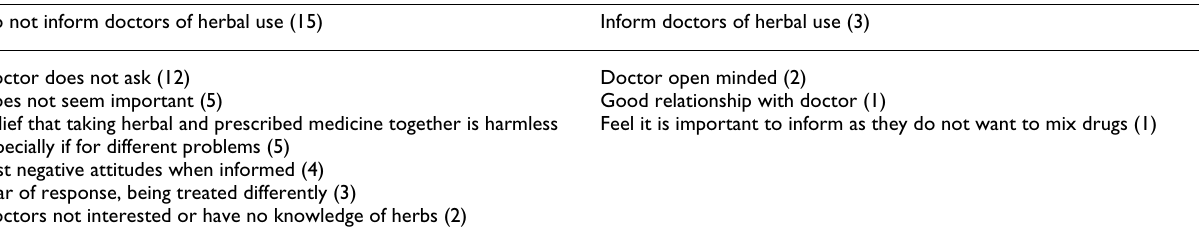
Doctor open minded (2) Good relationship with doctor (1) Feel it is important to inform as they do not want to mix drugs (1)